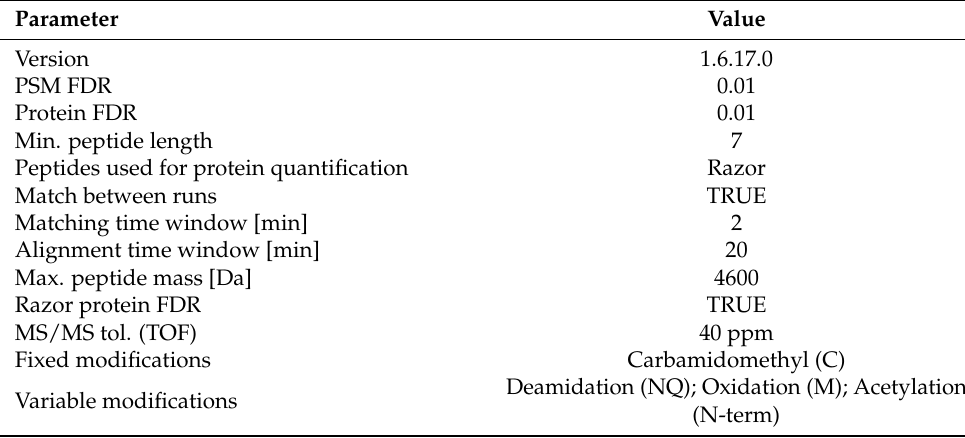
Table A3. Most important parameters of the MaxQuant database